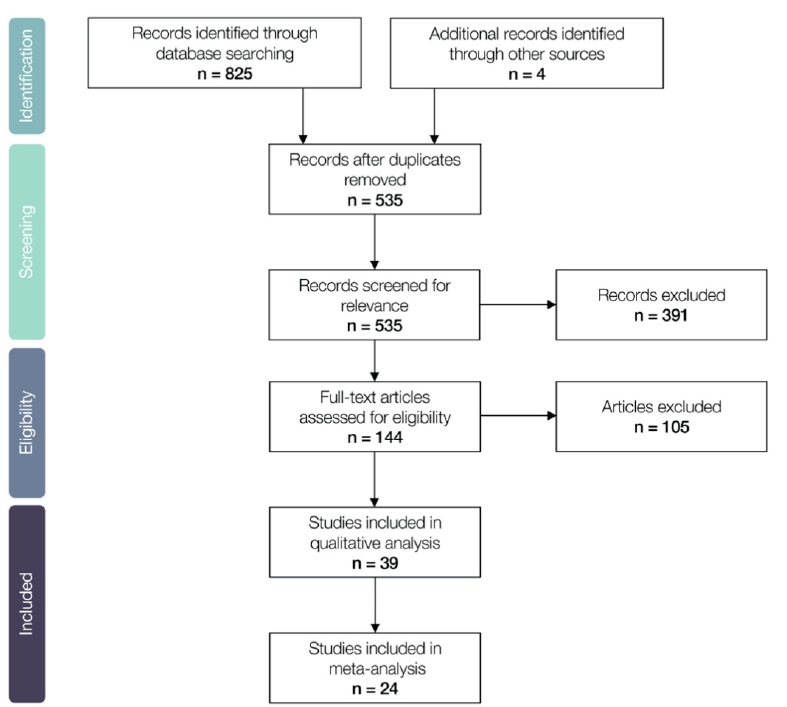
Figure 1. Preferred Reporting Items in Systematic Reviews and Meta-Analyses (PRISMA) flow diagram showing the number of articles identified, included and excluded through the different phases of our systematic review and meta-analysis.